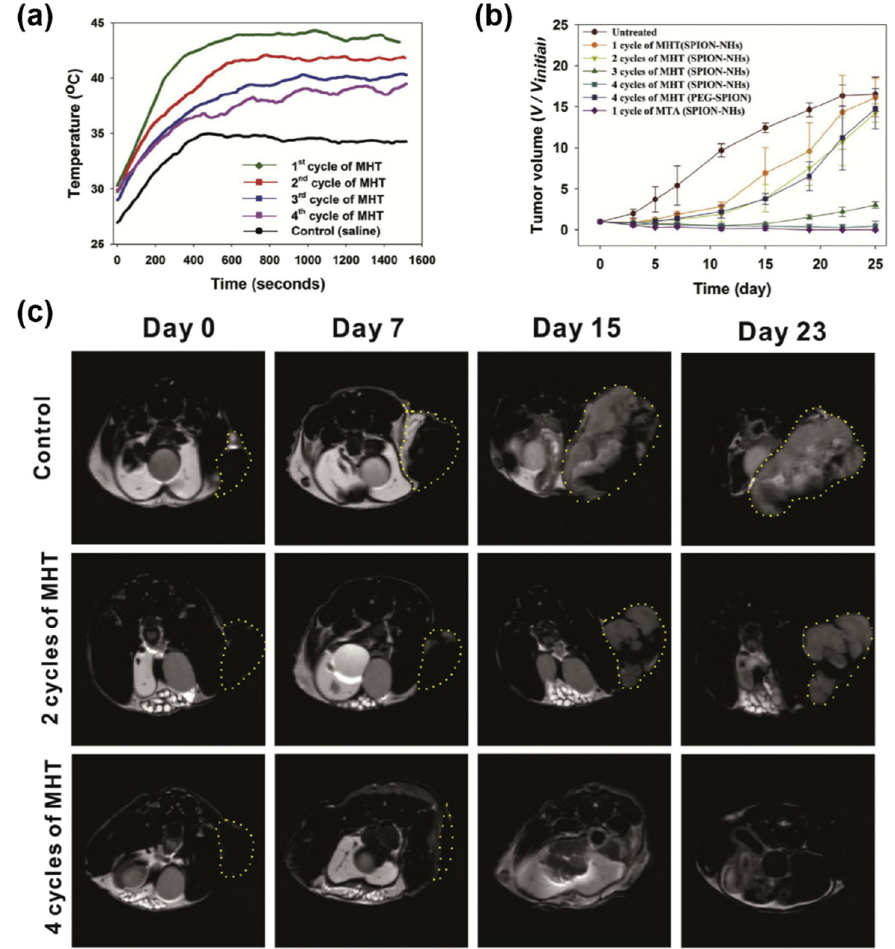
Figure 26. ( a ) Elevated tumor temperature versus time graphs induced by multiple MHT treatments after a single injection of PEGylated SPION aqueous solution. Mice were treated under the same AMF conditions. ( b ) In vivo therapeutic outcomes of multiple MHTs or single MTAs in tumor xenograft mice. Tumor volume (V/V inital ) was plotted versus time after treatment. ( c ) Long-term MRI monitoring of tumor xenografted mice injected with SPION-NHs. Tumor tissues are marked (yellow dashed line), and the black color within the tumor indicates the presence of SPIONs. Reproduced with permission from reference [93]. Copyright 2016 Elsevier.